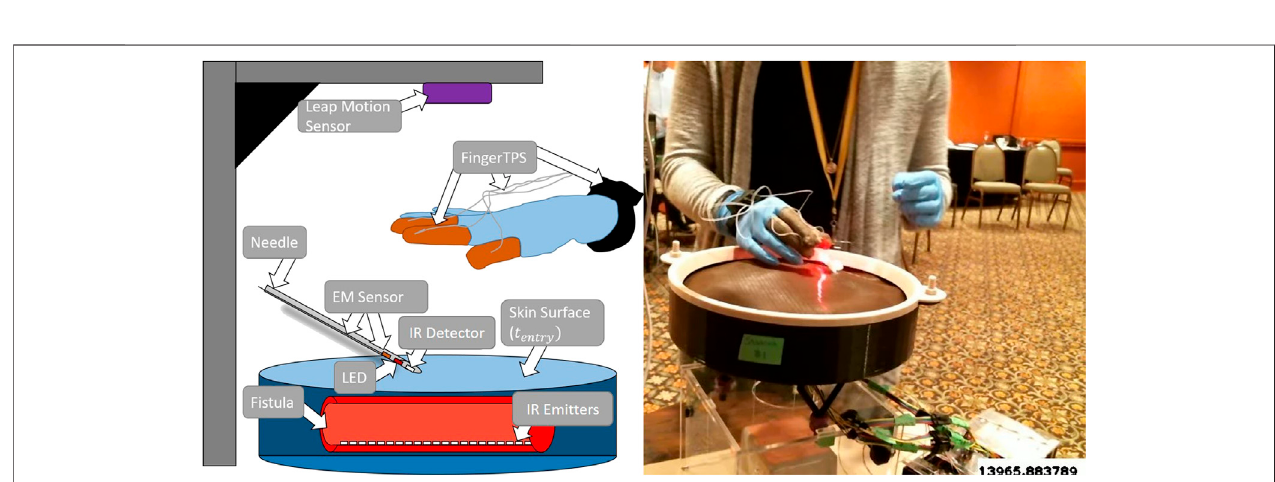
Frontiers in Robotics and AI |